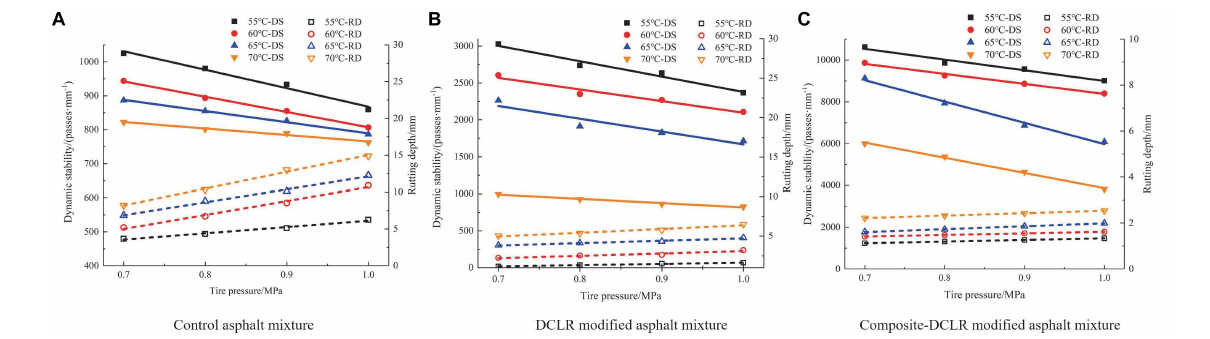
FIGURE 8 | Dynamic stabilities/rutting depths of three asphalt mixtures. (A) control asphalt mixture, (B) DCLR modified asphalt mixture, and (C) composite DCLR asphalt